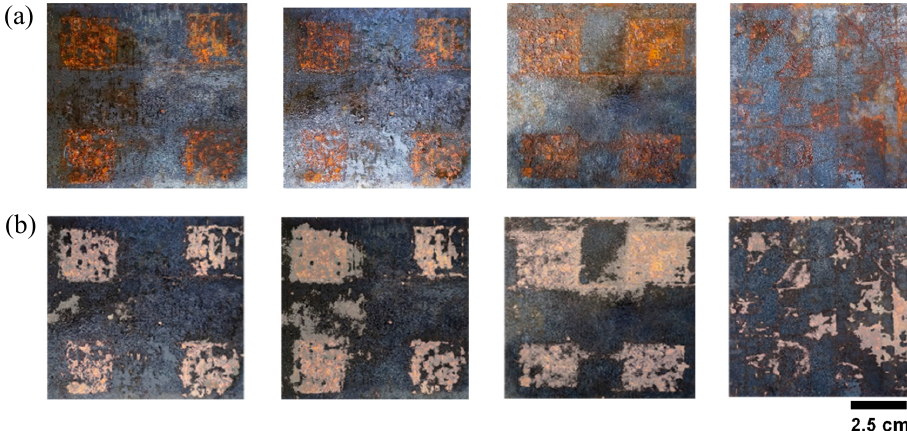
Figure 9. Test images of partially corroded steel plates wetted in water and acquired in natural daylight. ( a ) ground truth images, ( b ) MLP-based corrosion prediction.